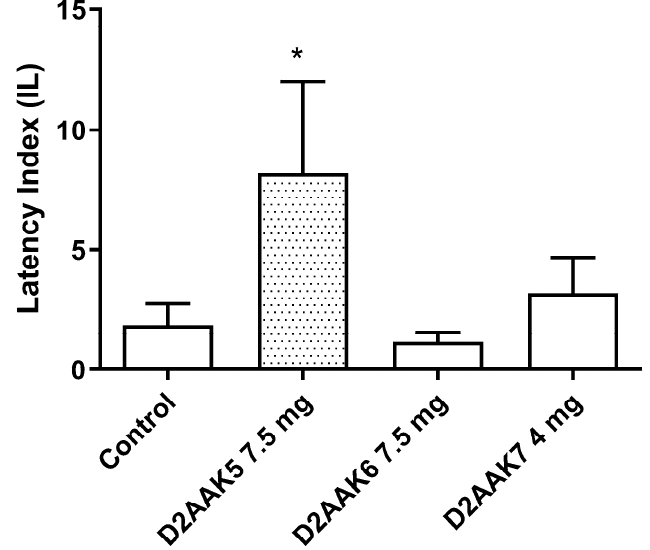
Figure 12. Effect of acute administration of D2AAK5, D2AAK6 (7.5 mg/kg), and D2AAK7 (4 mg/kg) on memory consolidation in the PA test mice. Appropriate groups of mice received injections of D2AAK5, D2AAK6 (7.5 mg/kg), and D2AAK7 (4 mg/kg) and vehicle i.p. on Day 1 immediately after the test and the rodents were retested 24 h later (i.e., on Day 2). The results are expressed as mean ± SEM of the one independent experiment. * p < 0.05 vs. control (Student’s t -test).